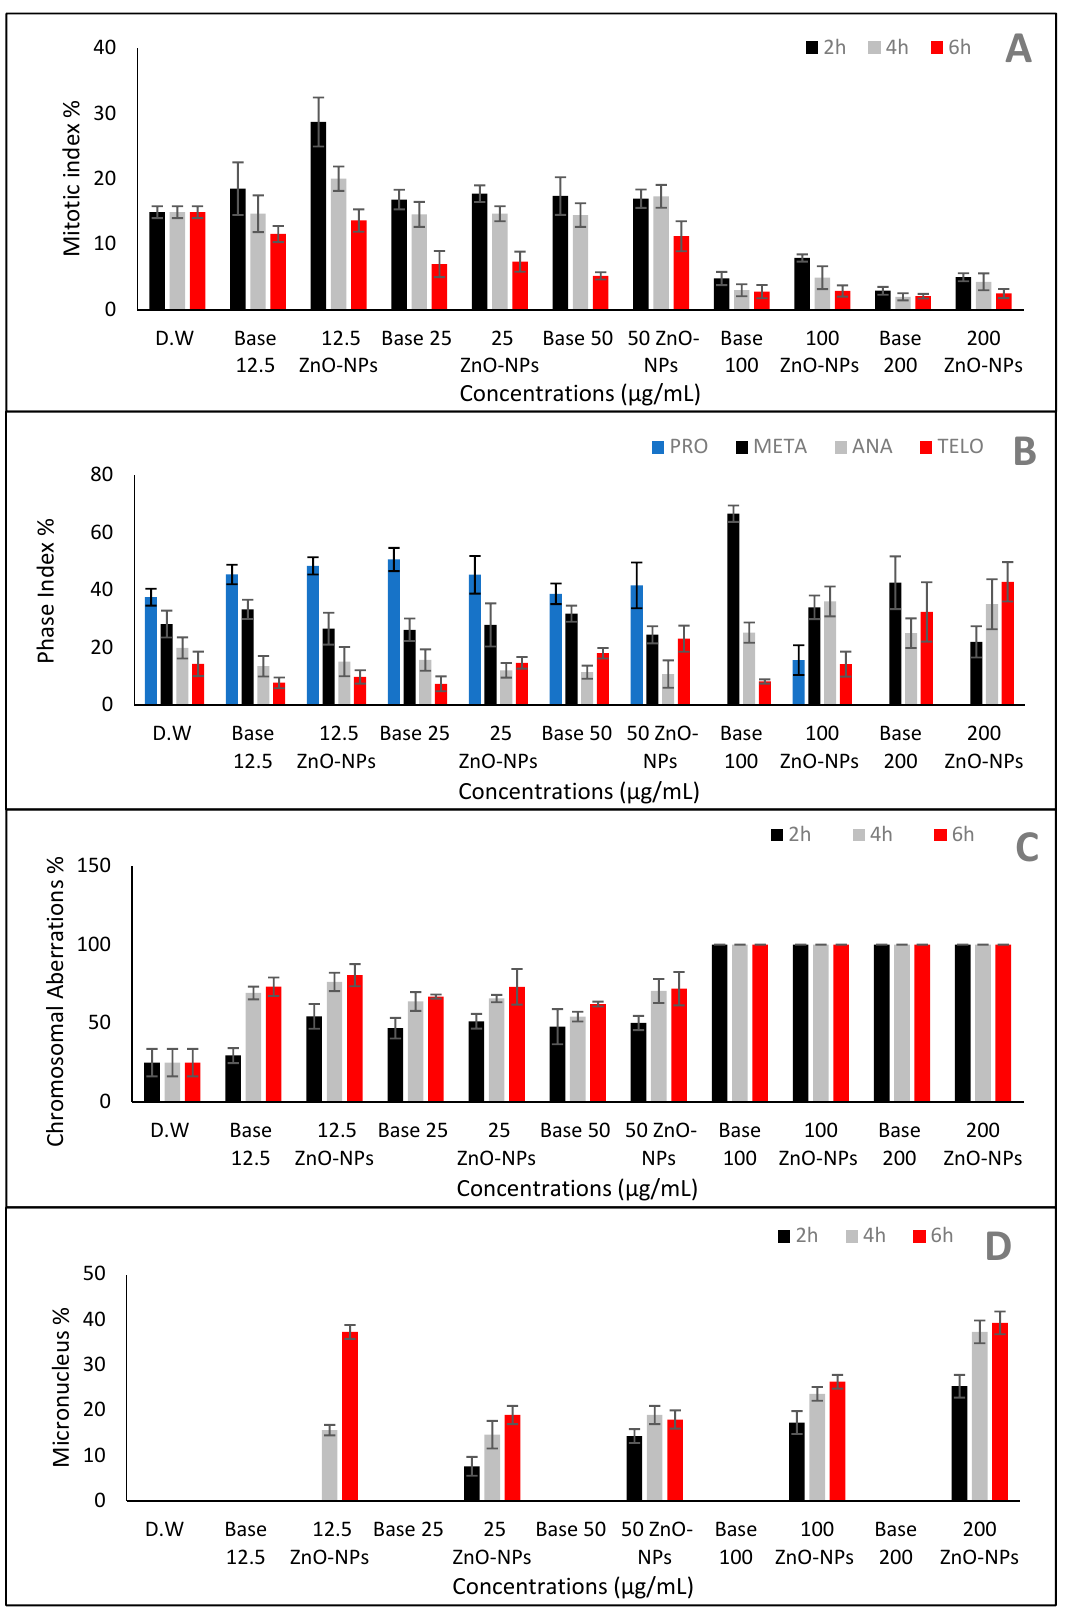
Figure 10. Cytotoxic effect of ZnO nanoparticles on root meristems of Vicia faba : ( A ) mitotic index (%), ( B ) phase index (%), ( C ) chromosome aberrations (%), ( D ) micronucleus (%).